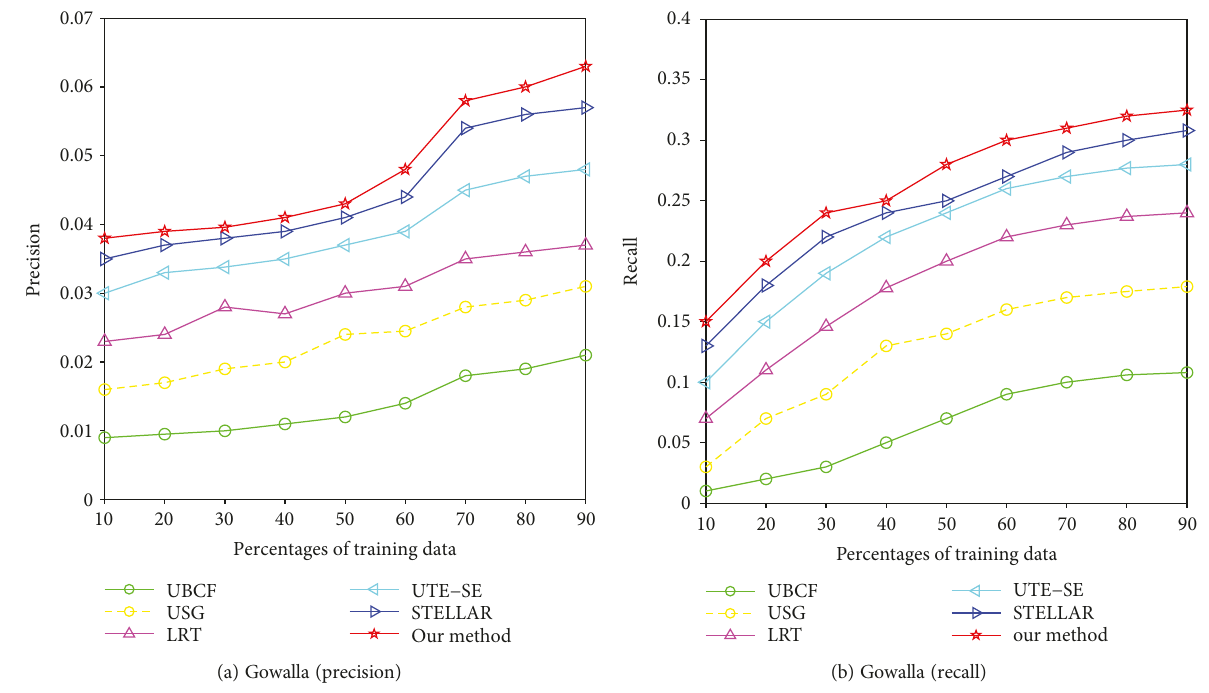
Figure 6: E ff ect of percentages of training data on the Gowalla dataset.